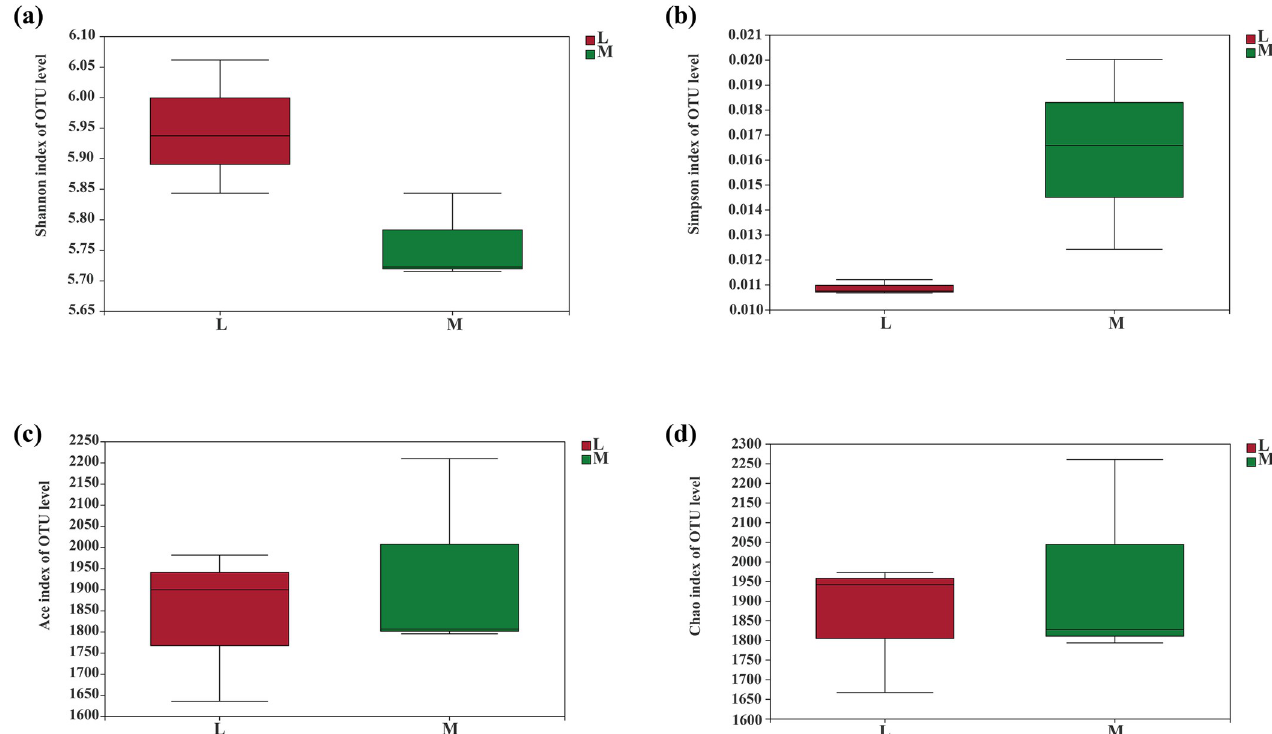
Fig 3. Soil bacterial diversity and richness between moss- (M) and non-moss growth (L) areas in litchi orchard: (a) Shannon index of OTU level. (b) Simpson index of OTU level. (c) Ace index of OTU level. (d) Chao index of OTU level.